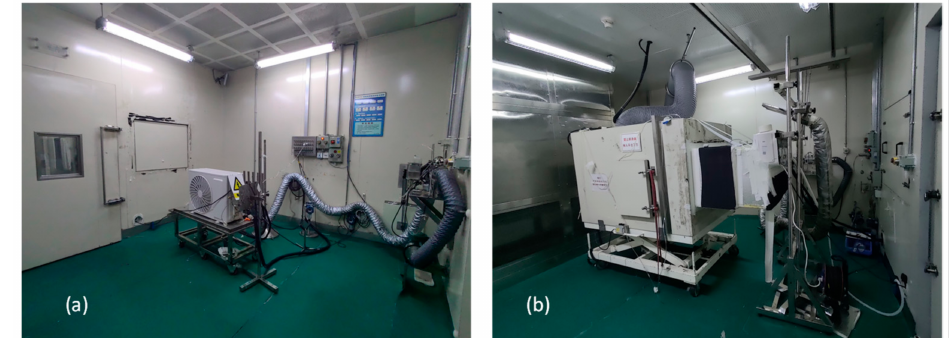
Figure 3. Pictures of the chamber: ( a ) outdoor chamber and ( b ) indoor chamber.